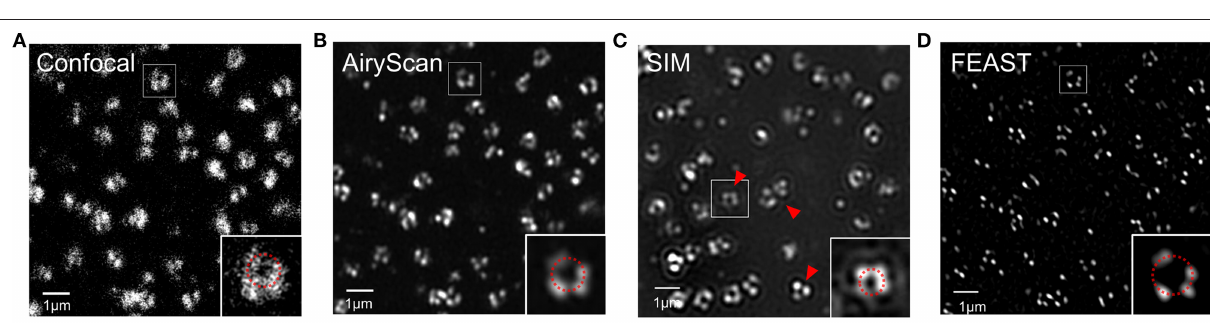
FIGURE 4 | Combination of expansion super-resolution and other super-resolution technologies (A) nNup153 taken in confocal mode after expansion. (B) nNup153 taken in Airyscan mode after expansion. (C) Image of nNup153 after structured illumination microscopy reconstruction. (D) Image of nNup153 after fluctuation-enhanced Airyscan technology reconstruction. Scale bars, 1 µ